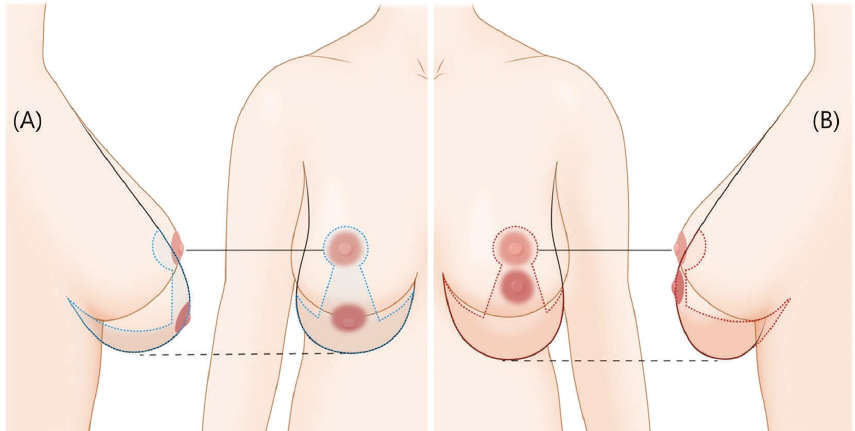
Figure 2: Concept illustration in ptotic and pseudoptotic breasts. The wise pattern of inverted T reduction mammoplasty is applicable in patients with (a) ptotic or (b) pseudoptotic breasts. However, customized designs are necessary for different skin excision areas, vertical line lengths, NAC locations, and lower pole shapes. NAC, nipple-areolar complex.